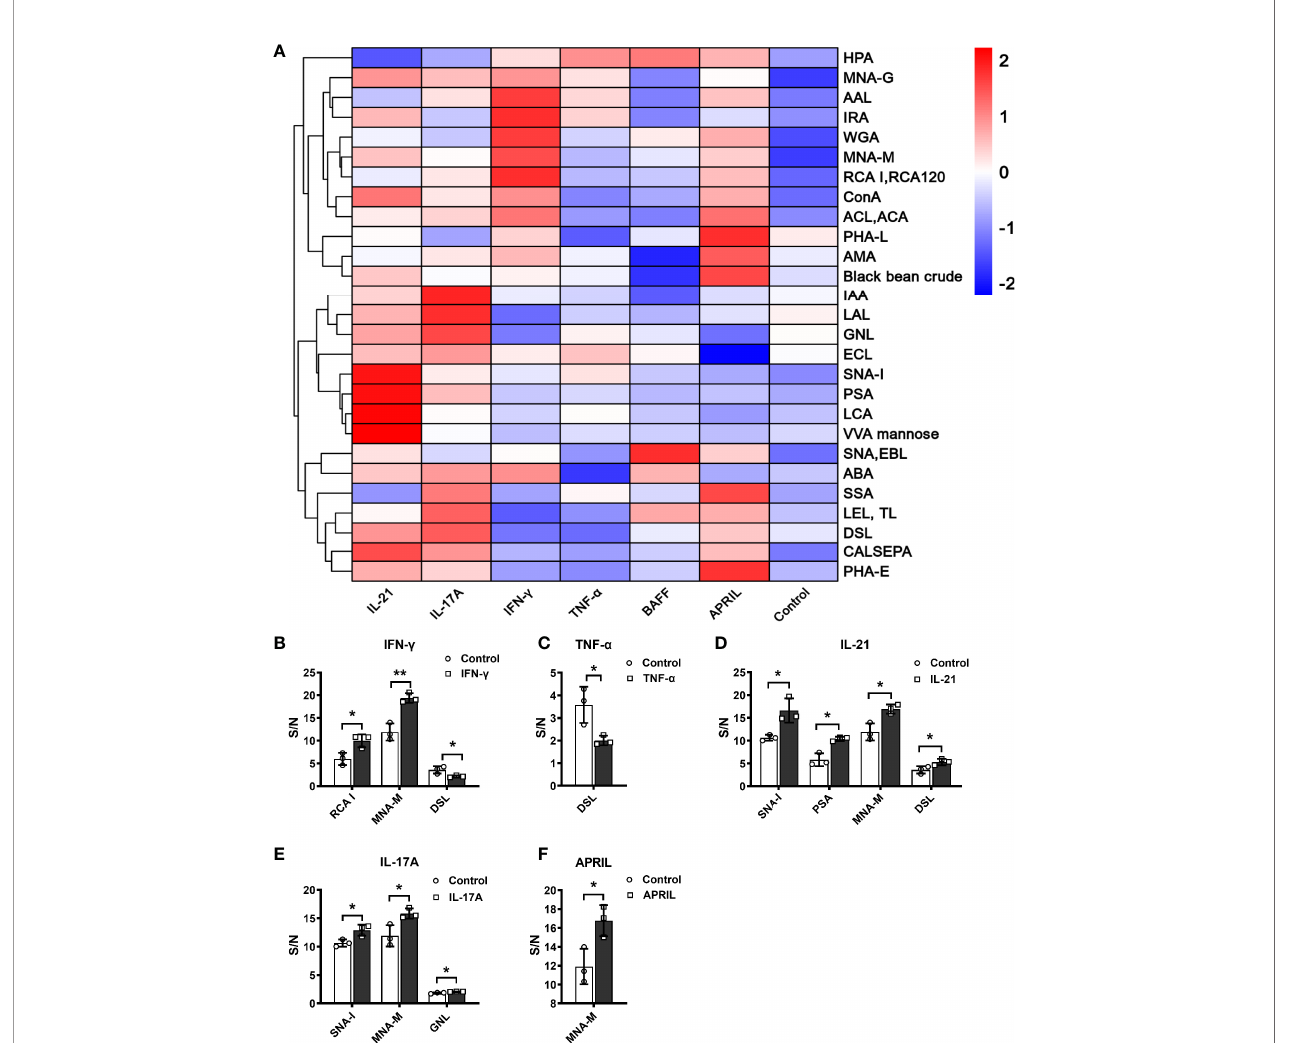
FIGURE 4 | S/N of detectable lectins for IgG under different cytokine stimulations. (A) Clustered heatmap of lectin IgG binding pro fi les. Detectable lectins were de fi ned as those with (1) an S/N > 1.2 for each lectin spot and (2) an S/N coef fi cient of variation (measured in triplicate) less than 30%. The detectable lectins are listed on the left vertical axis, and the samples under different stimuli are indicated along the horizontal axis, including IFN- g , TNF- a , IL-21, IL-17A, BAFF, and APRIL. Each square represents the S/N of a lectin binding pattern on IgG. The values of S/N were transformed by min – max normalization. The color bar represents the scale — red indicates a higher S/N, and blue indicates a lower S/N. (B – F) S/N of IgG with signi fi cant changes under stimulation by IFN- g , TNF- a , IL-21, IL-17A, and APRIL in vitro . The binding speci fi cities of lectins were SNA-I, SNA, and EBL for terminal Neu5Ac a 2 – 6/sialic acid (SA); RCA-I, ECL, PHA-L, PHA-E, MNA-G, ACL, ACA, and ABA for galactose (Gal); and DSL, LEL, TL, and WGA for N-acetylglucosamine (GlcNAc). The error bars represent the SD. * p < 0.05, ** p <